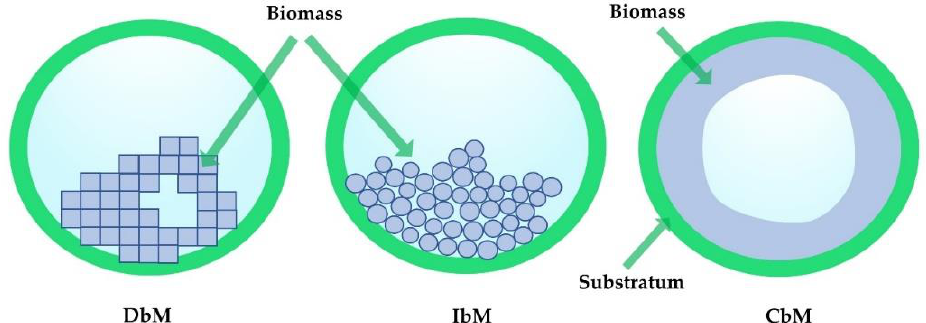
Figure 6. Schematic of the modeling strategies of biofilm development in a pore. Discrete biomass- based models (DbMs) can be established through cellular automaton (CA) in 2D and 3D space with discrete distribution directions and discrete displacement. Individual-based biomass models (IbMs) treat individual microbes as basic units, allowing cell variation and movement in a continuous direction and distance. In continuum biomass-based models (CbMs), the development process of biofilm growth is represented by differential equations.